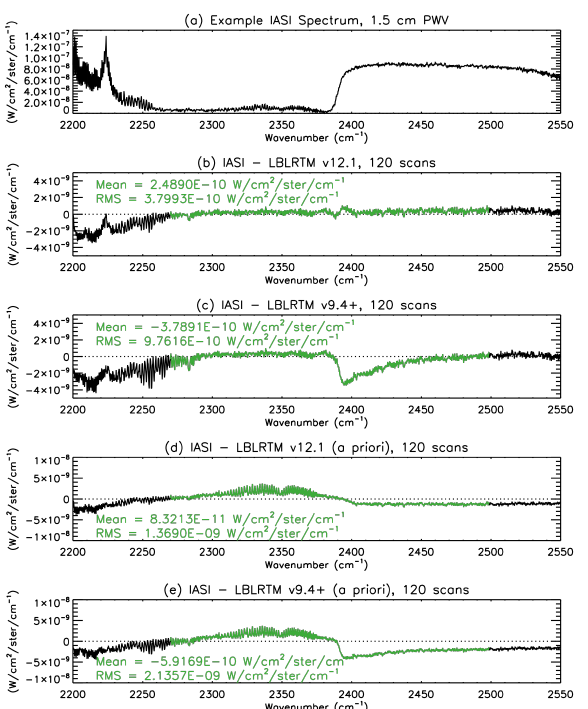
Fig. 9. (a) IASI-observed radiance spectrum in the ν 3 band of CO 2 for an example profile with 1.5cm PWV. (b) Mean of the final (a posteriori) radiance residuals for 120 spectra using LBLRTM v12.1. (c) Mean of the final radiance residuals for 120 spectra us- ing LBLRTM v9.4 + . (d) Mean of the a priori radiance residuals for 120 spectra using LBLRTM v12.1. (e) Mean of the a priori radiance residuals for 120 spectra using LBLRTM v9.4 + . The CO 2 ν 3 band, which was not used in the temperature retrievals, is highlighted in green. Note that the RMS due to instrument noise alone in this band is 2 . 4 × 10 − 10 Wcm − 2 ster − 1 cm.